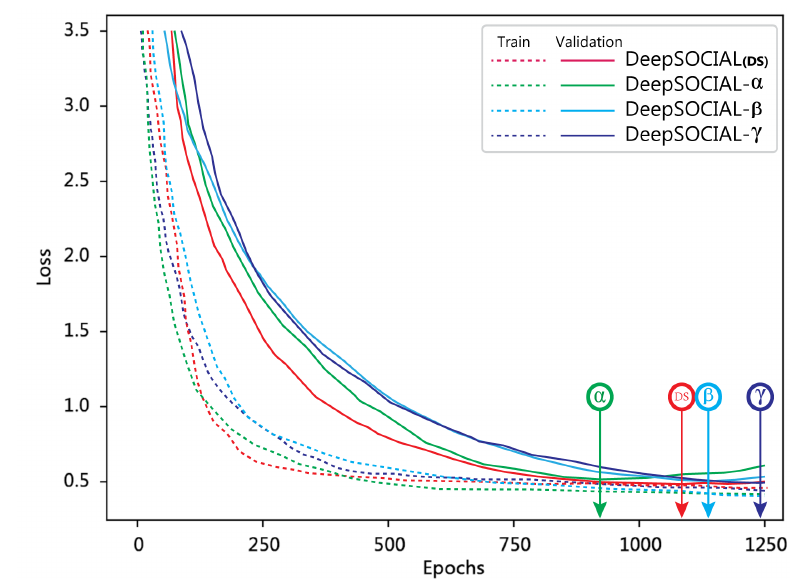
Figure 10. Training and validation loss of the DeepSOCIAL models over the Open Images